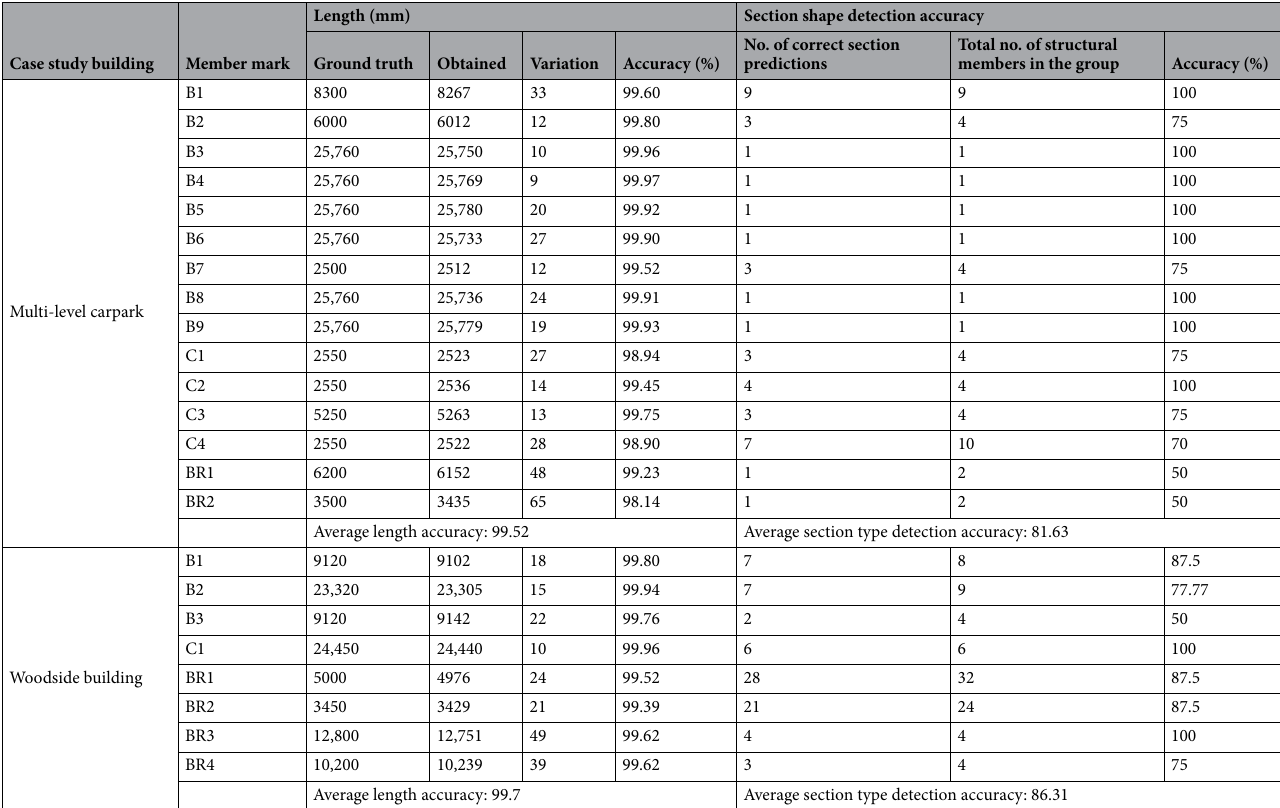
Table 3. Comparison between the obtained dimensions and ground truth data for study